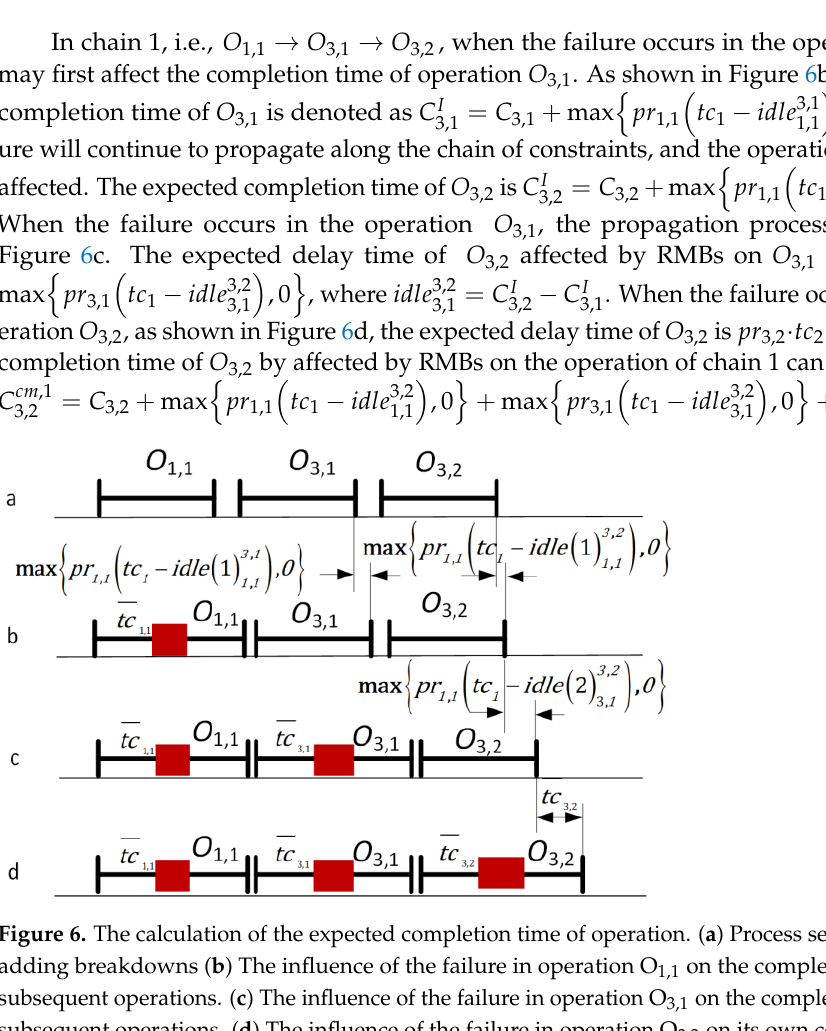
Figure 5. The Gantt chart for n = 3, m = 2.